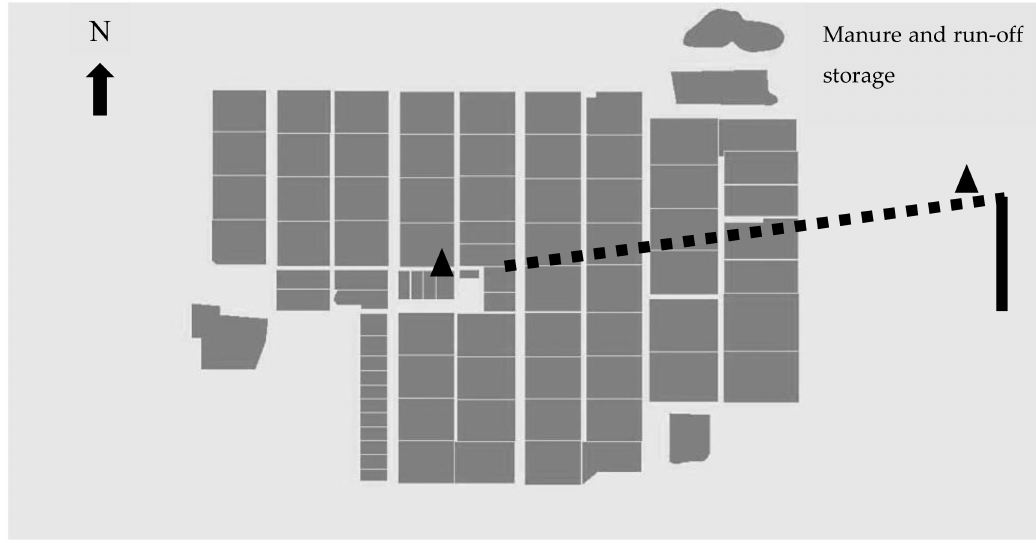
Figure 1. Study site with a Fourier Transform Infrared detector (FTIR) in the east field using long path (dashed) and slanted paths (solid) and the location of two sonic anemometers